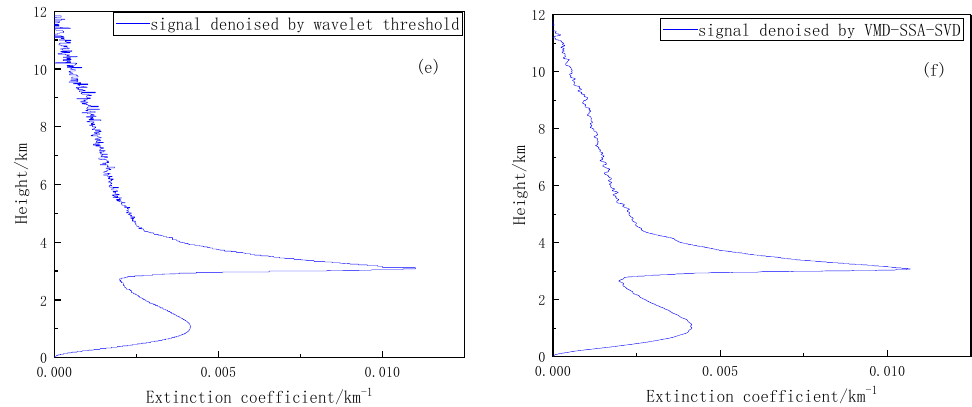
Figure 10. Denoised aerosol extinction coefficient profiles containing the inversion of one cloud return signal by different methods. ( a )Original signal. ( b ) The signal processed by the EMD method. ( c ) The signal processed by the EEMD method. ( d ) The signal processed by the CEEMDAN method. ( e ) The signal processed by the wavelet threshold method. ( f ) The signal processed by the VMD-SSA-SVD method.